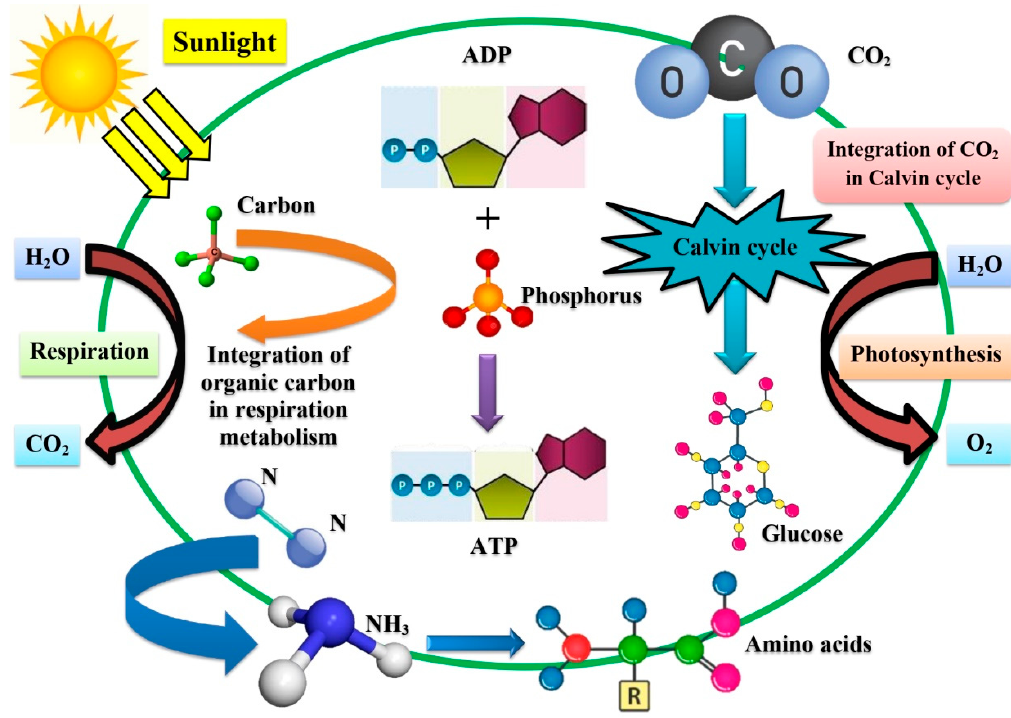
Figure 4. Nutrient removal in wastewater by microalgae.